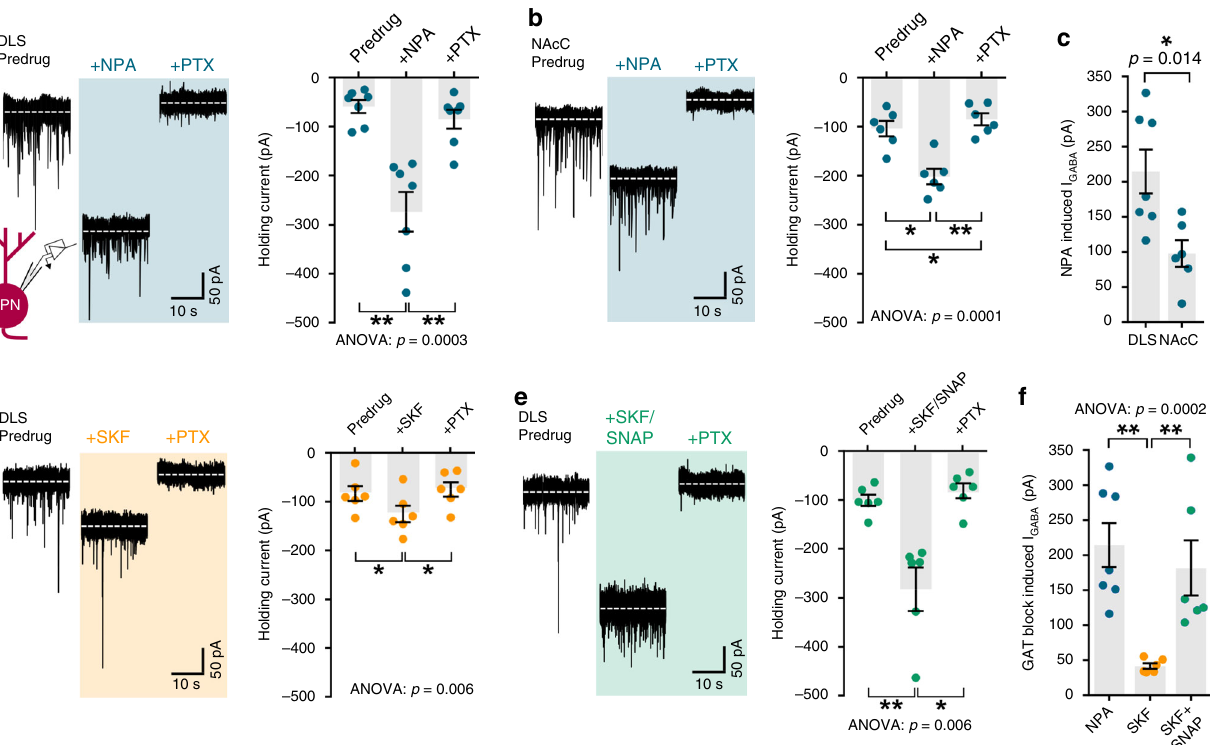
Fig. 3 Tonic GABA currents in striatal spiny projection neurons (SPNs) are augmented by GAT inhibition. a , b , d , e Left, representative continuous whole-cell recordings from SPNs in DLS ( a , d , e ) or NAcC ( b ) voltage clamped at − 70 mV in the presence of ionotropic glutamate receptor antagonists NBQX (5 μ M) and D-AP5 (50 μ M), before and during bath application of GAT inhibitor NPA (blue, 1.5 mM, n = 7 cells/5 mice for DLS in a , n = 6 cells/3 mice for NAcC in b ), GAT-1-speci fi c inhibitor SKF89976A (orange, 20 μ M, n = 6 cells/3 mice in d ), or the combined application of SKF89976A and GAT- 3-speci fi c inhibitor SNAP5114 (green, 50 μ M, n = 6 cells/4 mice in e ). GAT inhibitors increase the extracellular GABA A -mediated inward current, revealed by a shift in the holding current, and is reversed upon application of GABA A receptor antagonist picrotoxin (PTX, 100 μ M). Right, mean holding current in pA recorded in SPNs in control conditions, upon addition of GAT inhibitors and then PTX. c , f Mean tonic GABA A -receptor-mediated currents induced by GAT inhibition recorded from SPNs, calculated by subtracting predrug holding current from GAT block-induced holding current. Friedman ’ s ANOVA on * p < 0.05, ** p < 0.01. Error bars are ±SEM. Source data are provided as a Source Data fi